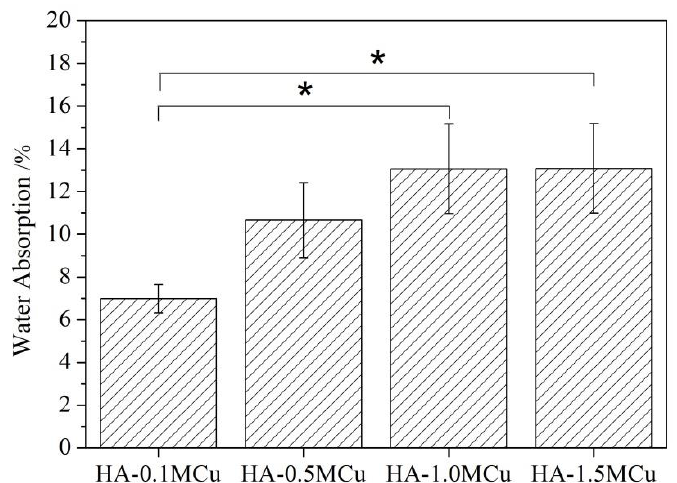
Figure 4. Water absorption of Cu-doped HA macrobeads after sintering. Asterisks (*) denote. significant differences (*p < 0.05).